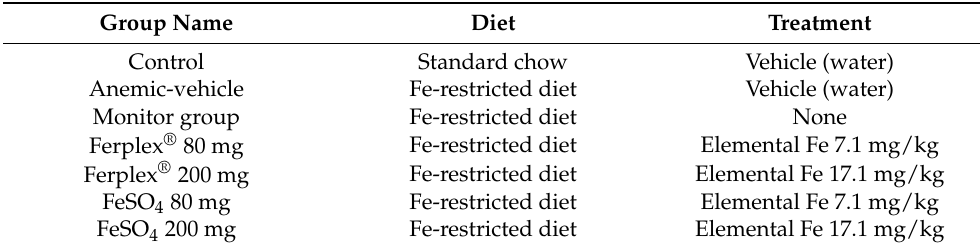
Table 1. Description of diet and treatment of respective